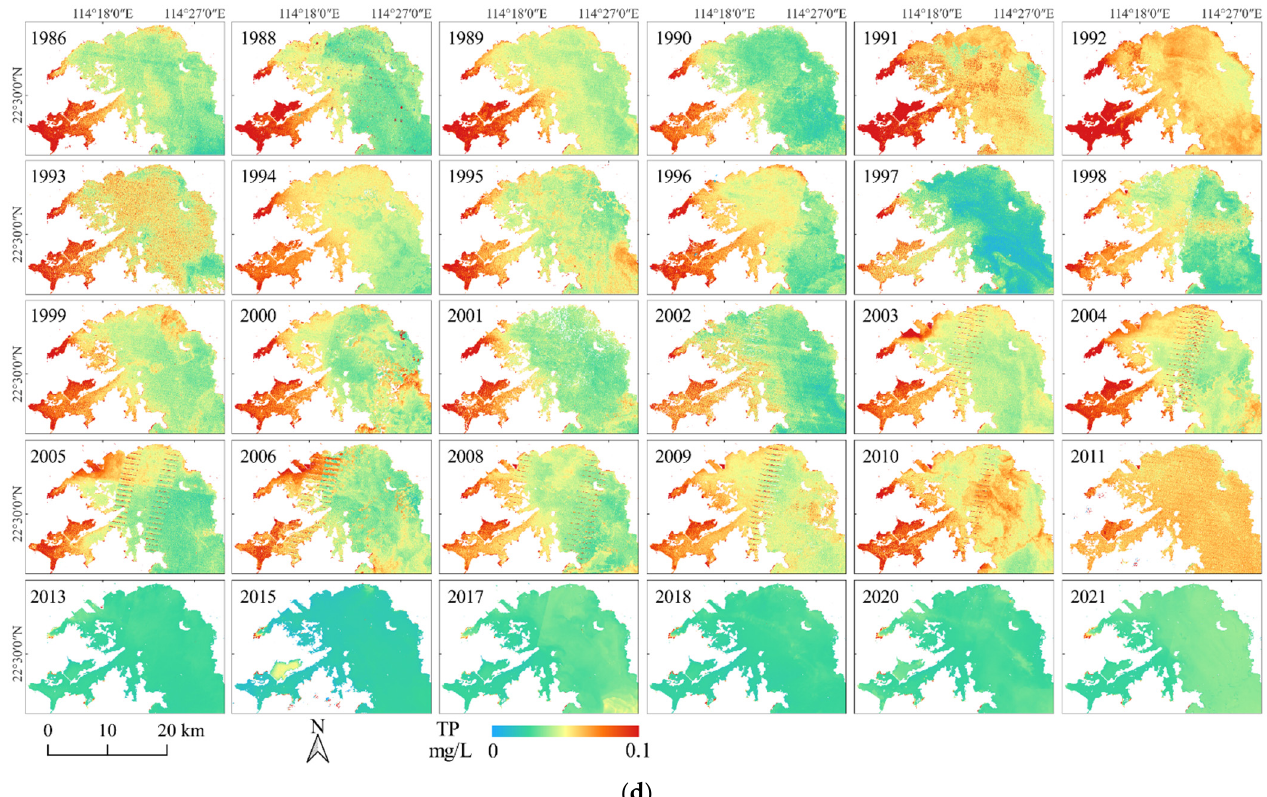
Figure 3. Spatial distribution of total nitrogen (TN) and total phosphorus (TP) in ( a , c ) the western part and ( b , d ) the eastern part of the study area.